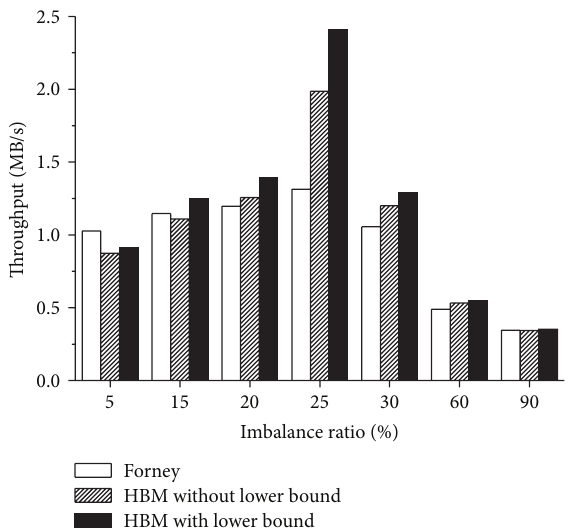
Figure 5: Throughput of Forney, HCM with and without balance scheme under imbalance